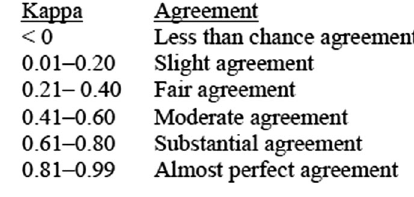
FIG. 4. An interpretation of Cohen ’ s kappa [35].